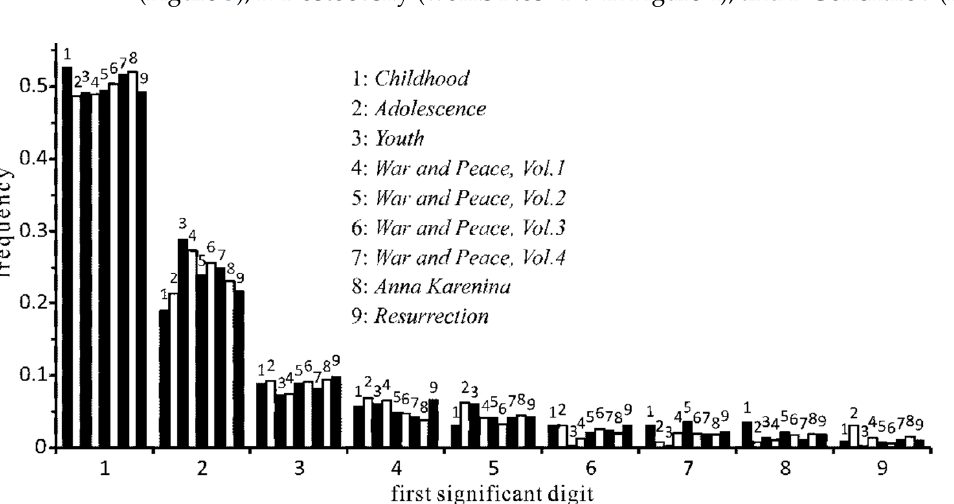
Figure 3. The distribution of the first significant digits of numerals in the works by L. Tolstoy.